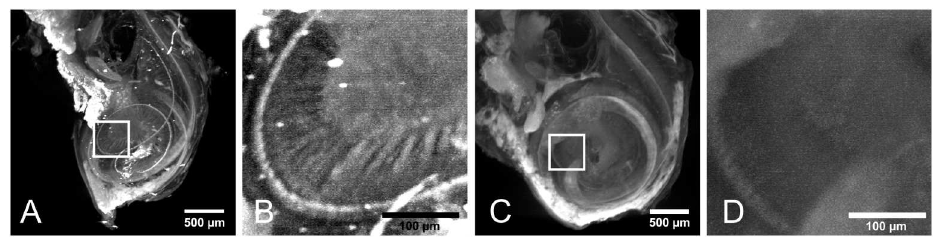
Fig 2. Maximum intensity projections (MIP) were performed on the reconstructed data of samples 1 and 2. (A) MIP of sample 1. The labeledneurofilament appearsas a helicalshapeinside the cochlea.(B) Highermagnification of the highlightedarea in A. The dendritesof the spiralganglionsare visible. (C) Negativecontrol (sample 2). Only autofluorescence and nonspecific binding shows the outer shapeof the cochlea.(D) Highermagnification of the highlighted area in